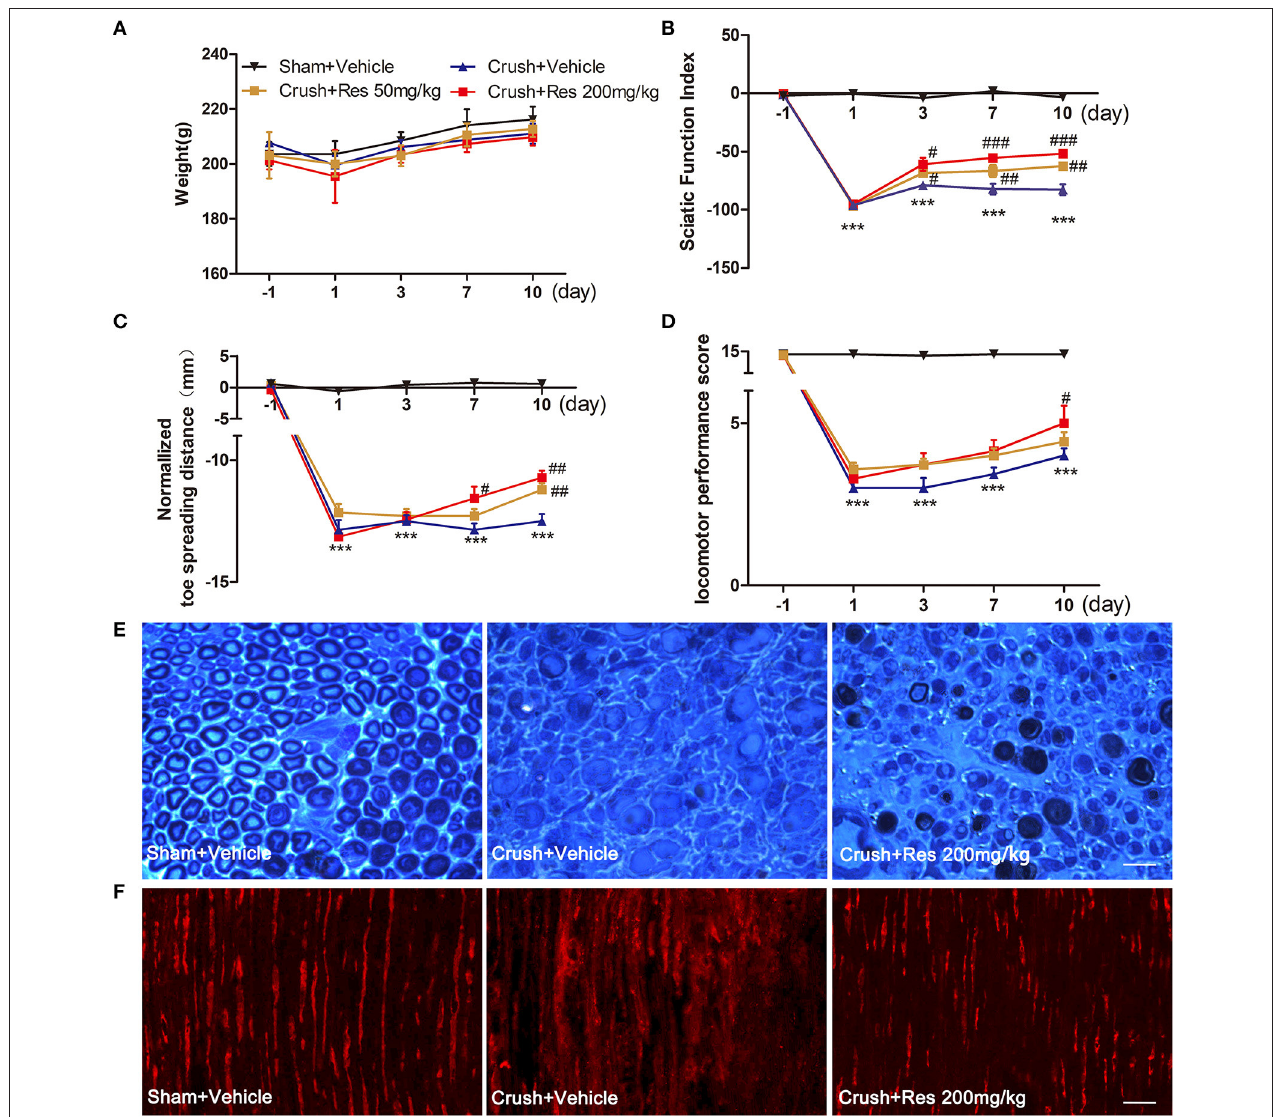
FIGURE 1 | Resveratrol (Res) dose-dependently improved motor function and nerve regeneration after crush injury. (A) Rats did not lose weight either after the sciatic nerve crush injury or after the daily intraperitoneal administration of Res at a dose of 50 mg/kg or 200 mg/kg for 10 consecutive days. (B–D) The sciatic function index, normalized toe spreading distance and locomotor performance score were significantly decreased from the first day to 10 days after crush injury (compared Crush + Vehicle with Sham + Vehicle, *** P < 0.001 . n = 12 for each group). The sciatic nerve index was increased by the both doses of Res from the third to the tenth days after the treatment. The normalized toe spreading distance was increased by 50 mg/kg and 200 mg/kg Res on the tenth day and from the seventh to tenth days after the treatment, respectively. The locomotor performance score was increased by 200 mg/kg Res on the tenth day after the treatment (compared Crush + 50 mg/kg Res or Crush + 200mg/kg Res with Crush + Vehicle, # P < 0.05 , ## P < 0.01 , ### P < 0.001 . n = 12 for each group). (E) Representative images of toluidine blue staining showed the degeneration and regeneration of myelinated axons in the crush injury rats receiving the vehicle and Res treatment, respectively. The transverse sections were obtained from the distal part of the injured nerve. Scale bar = 50 µ m. (F) Representative images of immunofluorescence staining showed the degeneration and regeneration of NF200 positive axons (red) in the crush injury rats receiving the vehicle and Res treatment, respectively. The longitudinal sections were obtained from the distal part of the injured nerve. Scale bar = 50 µ